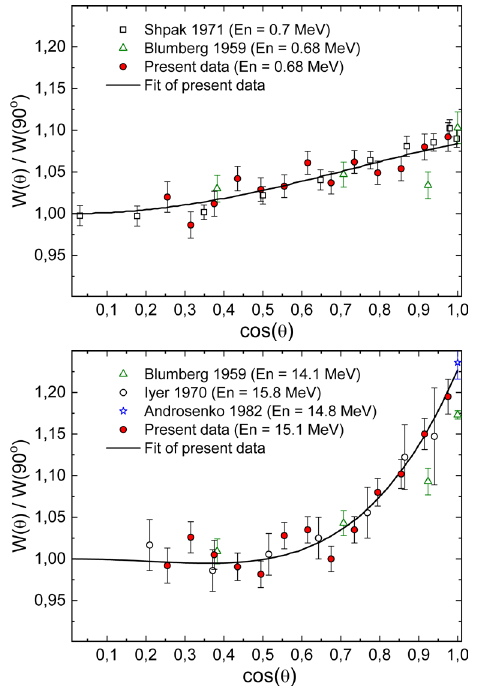
Figure 2. Angular distributions of FFs for 239 Pu for two char- acteristic energies of neutrons ( ∼ 0.7 and ∼ 14 MeV) compared with other EXFOR data [10–13]. Error bars are statistical errors. The solid lines are approximations of data by the sum of even Legendre polynomials up to the fourth